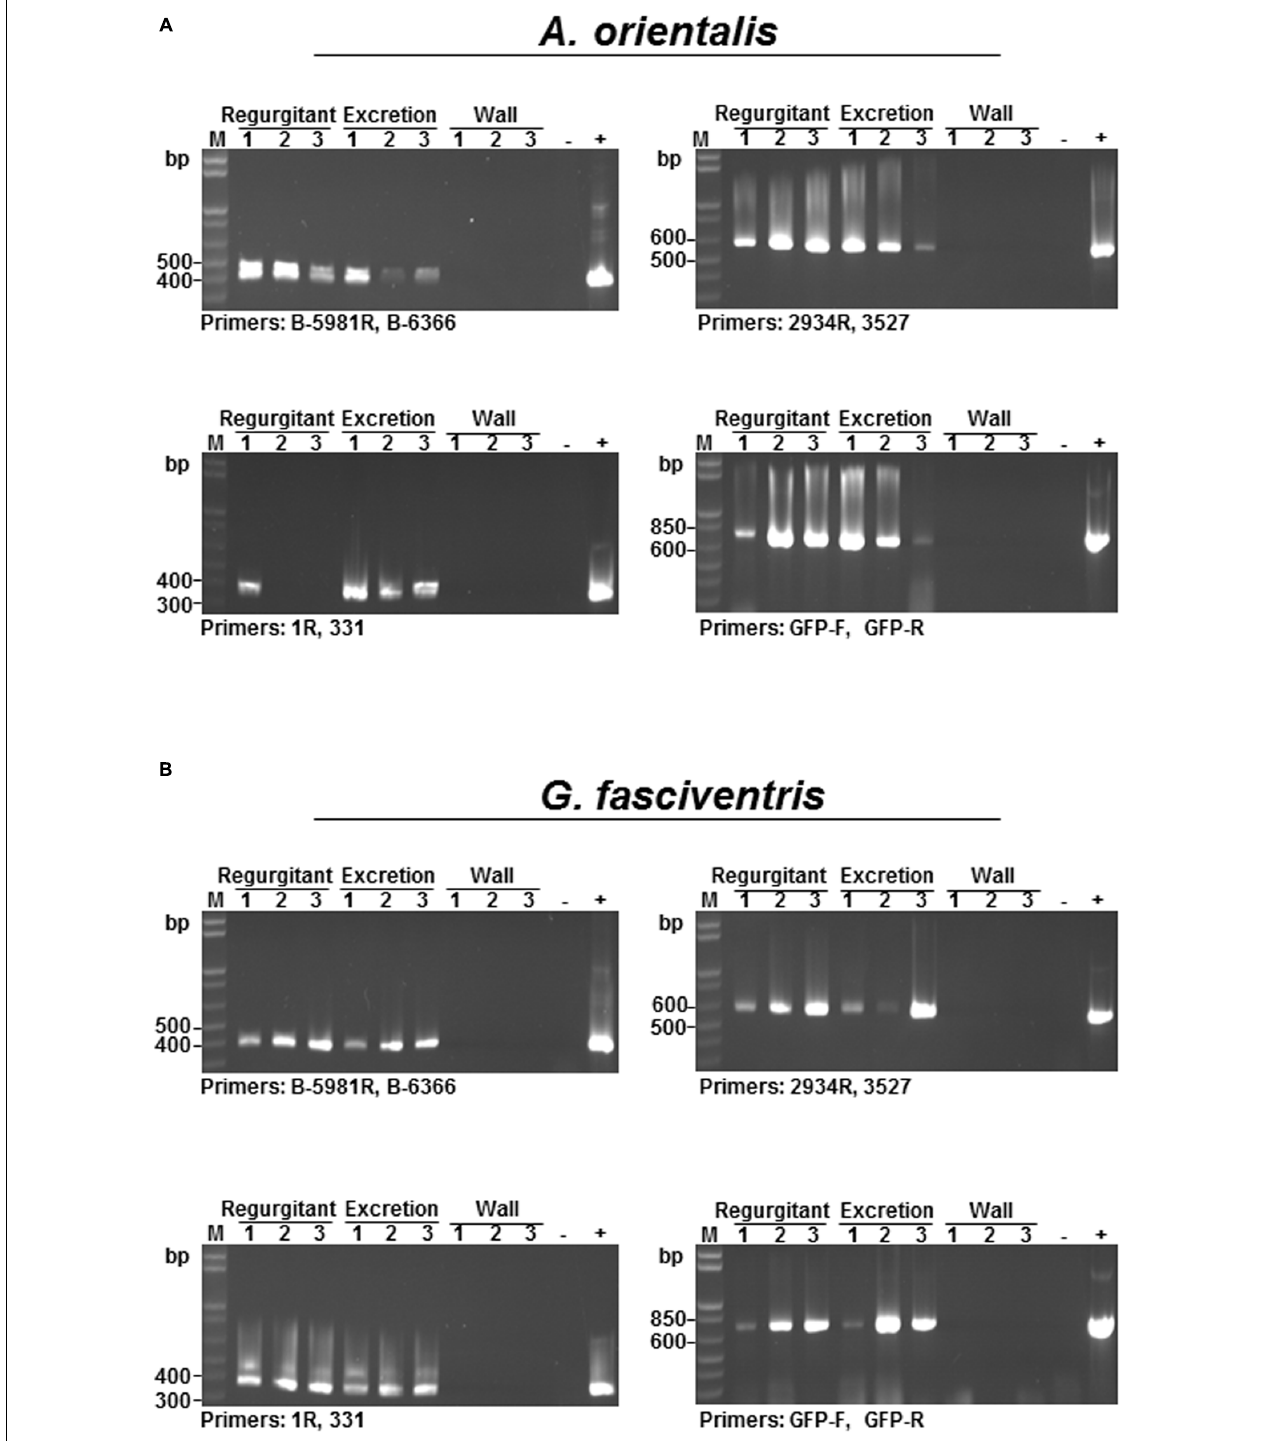
FIGURE 5 | Detection of GFP-tagged BaMV in the regurgitant and excretion fluids of dipteran insects. To investigate whether BaMV RNA could pass through the digestive systems of diptera insects, the reguritant and excretion fluids (as indicated on the top of the lanes) were collected from A. orientalis (A) and G. fasciventris (B) fed with GFP-tagged BaMV-containing media and subjected to RT-PCR analysis for the presence of BaMV RNA, using different primer pairs (as indicated at the bottom of each gel). To test whether the walls of the feeding tube were contaminated during the feeding process, aliquots of nucleic acid extraction buffer (2 µ l) were used to elute materials surrounding the regurgitant or excretion droplets, and subjected to RT-PCR analysis concurrently (lanes labeled “Wall”). For the positive control, 1 µ l of GFP-BaMV-supplemented medium was assayed concurrently. Lane M, size marker.